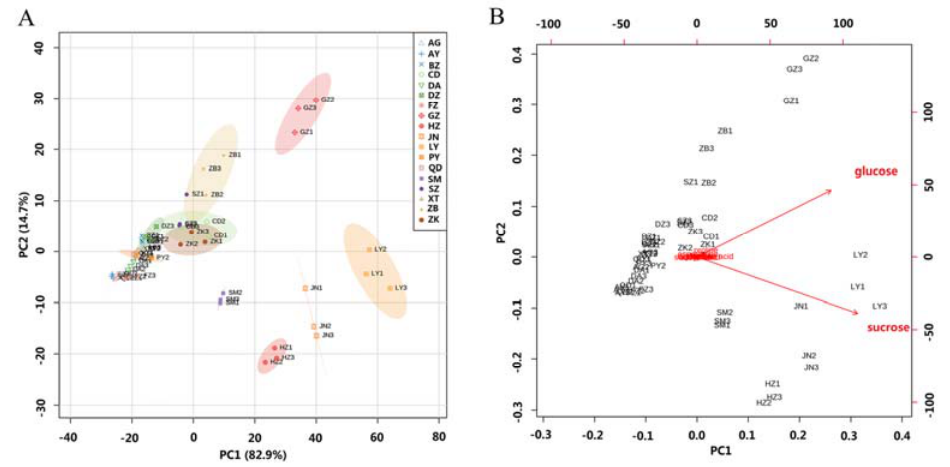
Figure 4. Scores plot ( A ) and biplot ( B ) of PCA model established with the quantitative NMR data.